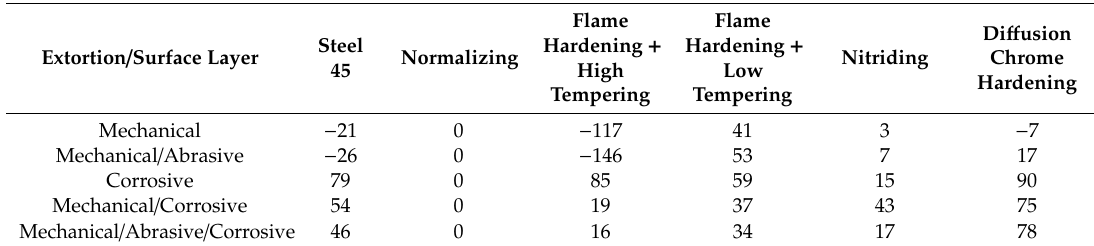
Table 12. Changes in wear resistance in % of various variants of treatments in relation to the normalized layer for individual